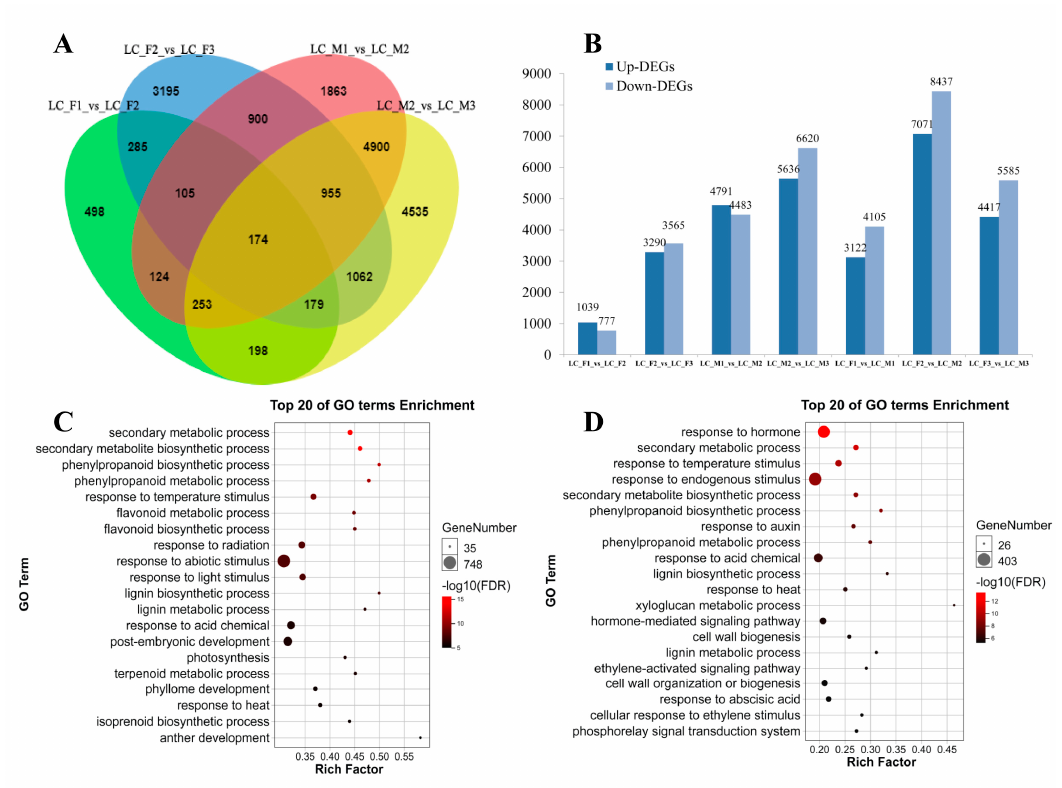
Figure 2. Analysis of RNA-seq in male and female flower. ( A ) Venn diagrams of di ff erentially expressed genes (DEGs) among the three stages in the female and male flower; ( B ) up-DEGs and down-DEGs were showed in male and female flower; ( C , D ) top 20 of gene ontology (GO) terms enrichment in the male and female flower,